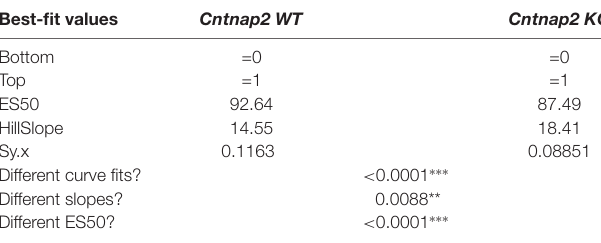
TABLE 1 | Comparison of sigmoidal curve fit of ASR I-O function with magnitude scaled between 0 and 1 in Cntnap2 WT and KO rats corresponding to Figure 3G . Best-fit values Cntnap2 WT Cntnap2 KO Bottom =0 =0 Top =1 =1 ES50 92.64 87.49 HillSlope 14.55 18.41 Sy.x 0.1163 0.08851 Different curve fits? < 0.0001 ∗∗∗ Different slopes? 0.0088** Different ES50? < 0.0001